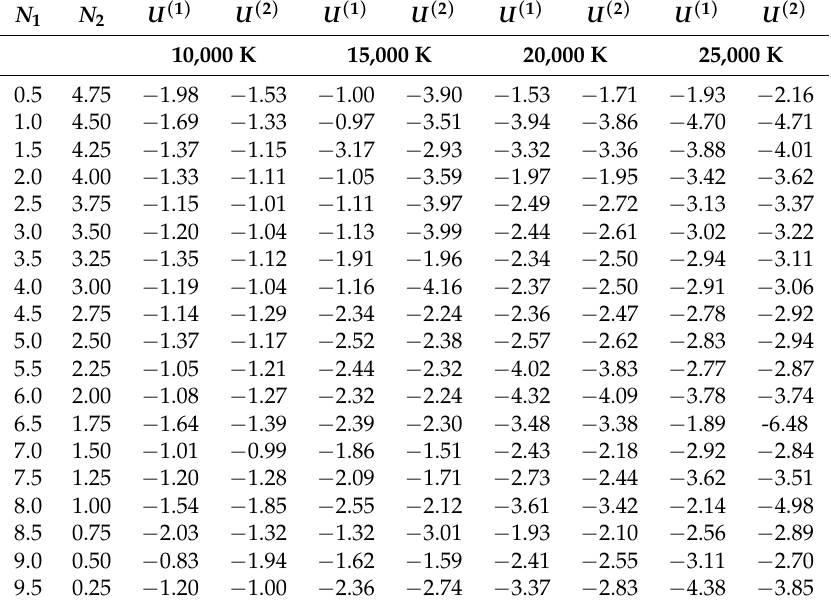
Table 3. The potential energies U ( 1 ) (in eV) and U ( 2 ) (in eV) for the case of Z 1 = 1 and Z 2 = 2 at N e = 10 19 cm − 3 and T = 1 × 10 4 , 1.5 × 10 4 , 2.0 × 10 4 , and 2.5 × 10 4 K. The densities N 1,2 are in 10 18 cm − 3 .